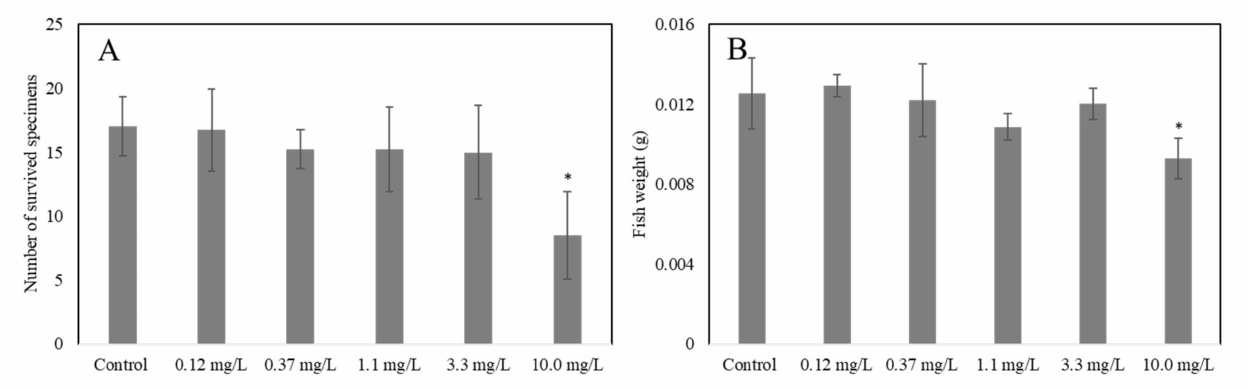
Figure 6. Significant effects indicated by asterisks (* p < 0.05), control versus treated, induced in D. rerio by both ELT-dp (( A ); survival) and ELT-dg (( B ); fish weight)